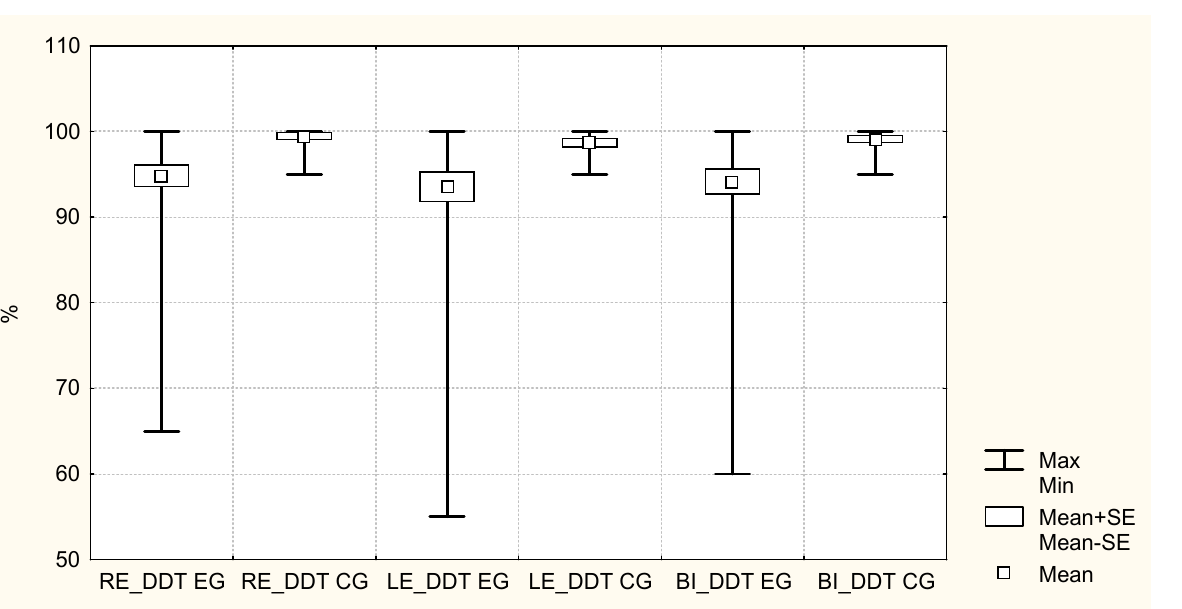
Figure 3. Boxplot of the exposed group (EG) and control group (CG) participants’ scores in the dichotic digits test (DDT) of the right ear (RE), left ear (LE), and binaural (BI).